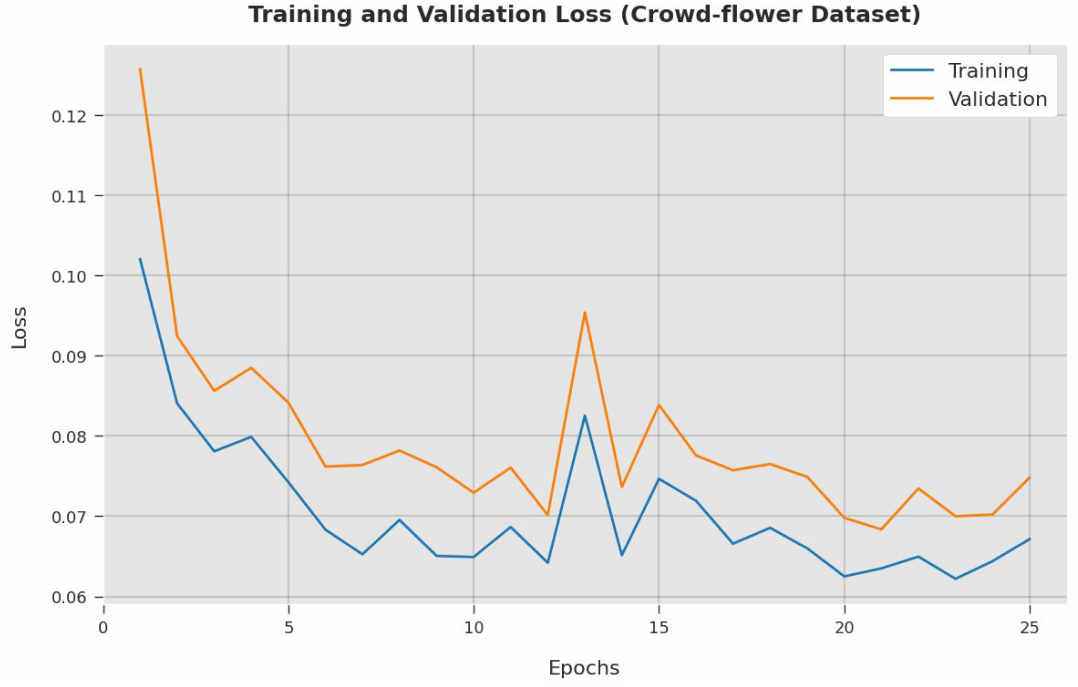
Figure 14. TL and VL analysis of ESGONLP-HSC algorithm under Crowd-flower